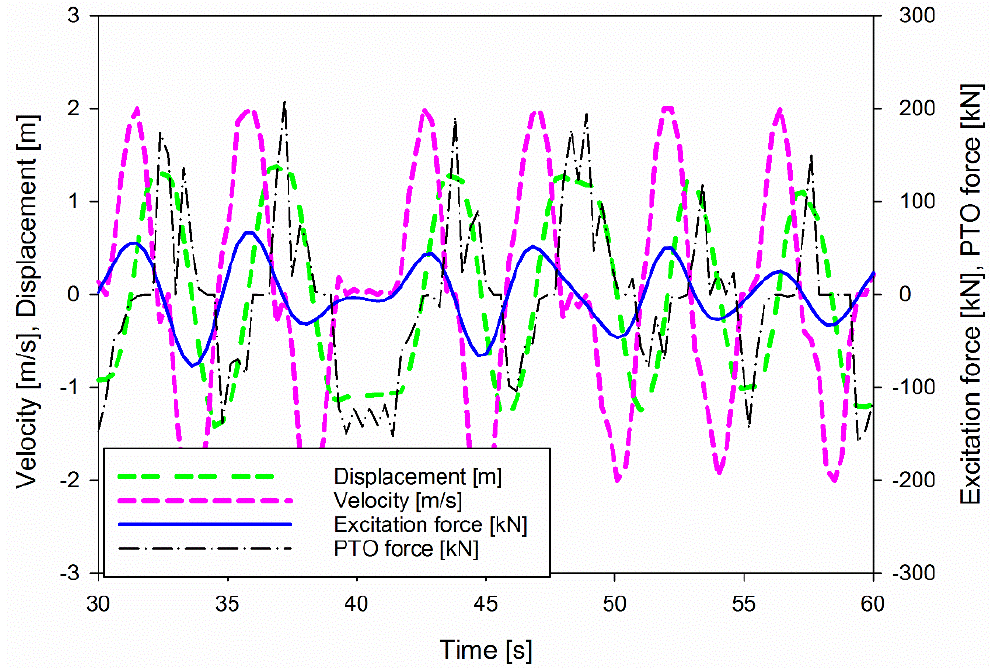
Figure 5. Velocity and excitation force of the WEC under the NPC restricting the sign of C to be nonnegative. Constraints are (cid:1848) = 2.0 m, (cid:1846) = 5.24 (cid:1834) (cid:3046) (cid:3043)